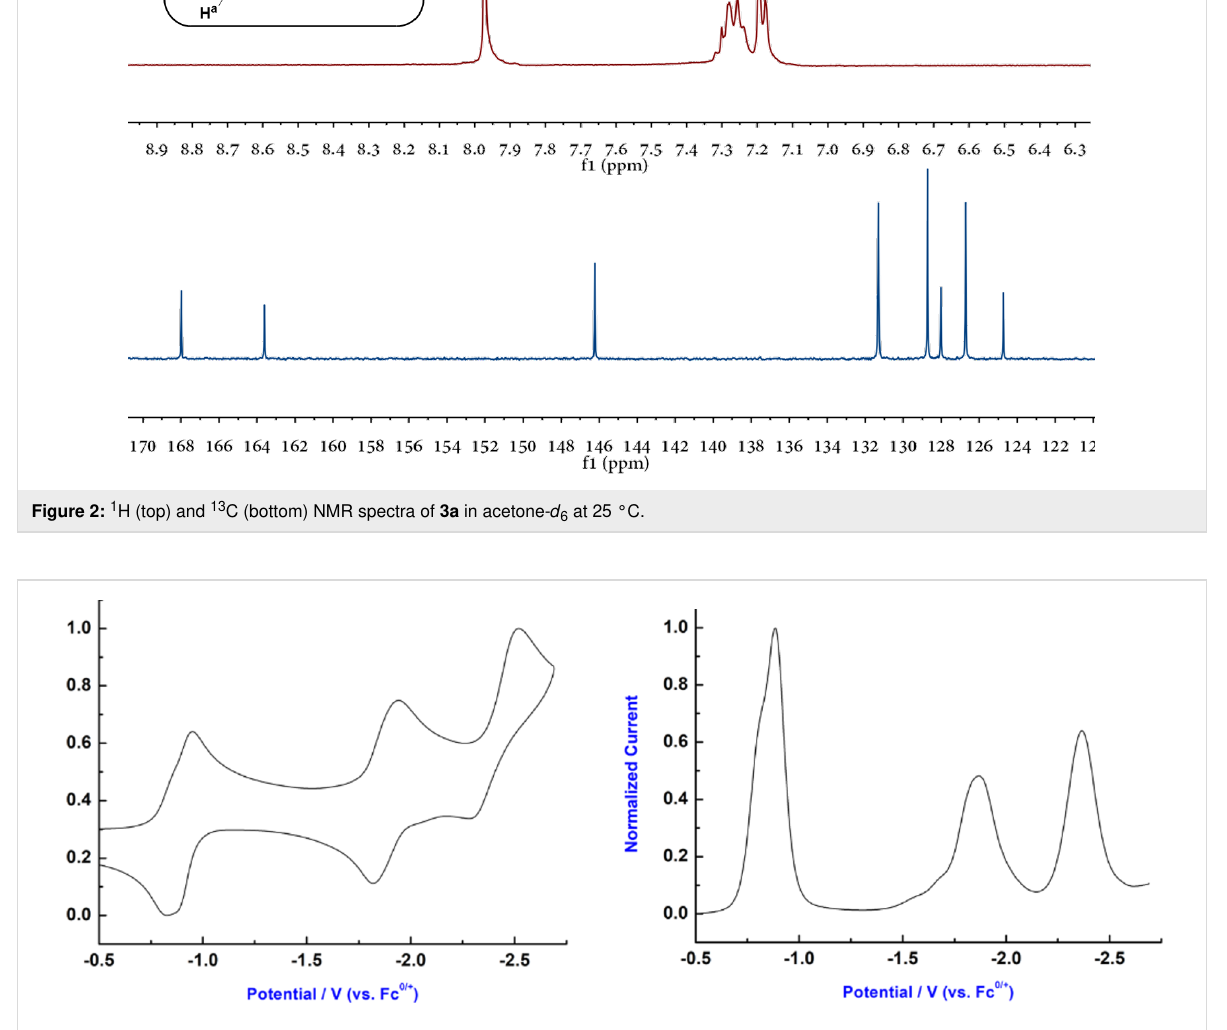
Figure 3: Normalized cyclic voltammograms (left) and differential pulse voltammograms (right) of 3a . CV and DPV were recorded (scan rate 100 mV·s − 1 ) using a glassy carbon electrode. All of the experiments were performed at 298 K in argon-purged MeCN solutions 0.5 mM) with 0.01 M of [Bu 4 N] + [PF 6 ] − as the supporting electrolyte. Potentials were recorded versus Fc +